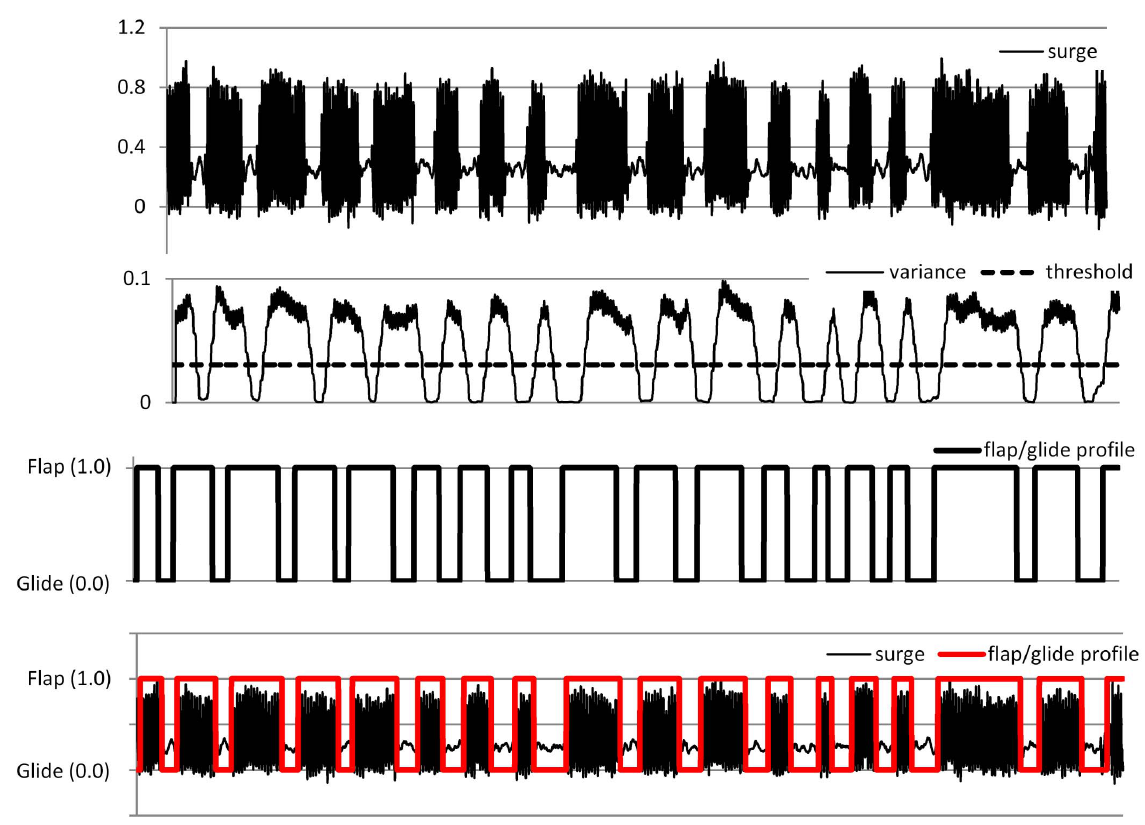
Figure 3. Identification of the different phases during the flight of a gannet. Flapping and gliding behaviours recorded in the surge (antero-posterior) acceleration axis by an accelerometer fitted to the back of a northern gannet ( Sula bassana ) (top) are separated by the running variance (middle-top), producing a binary signal (middle-bottom). The alignment of this signal with the raw data supports the behavioural classification (for details see text). (Figure 3). Based on this binary classification of the flight data, it was then possible to describe and compare profiles of flapping and gliding behaviours among the birds.